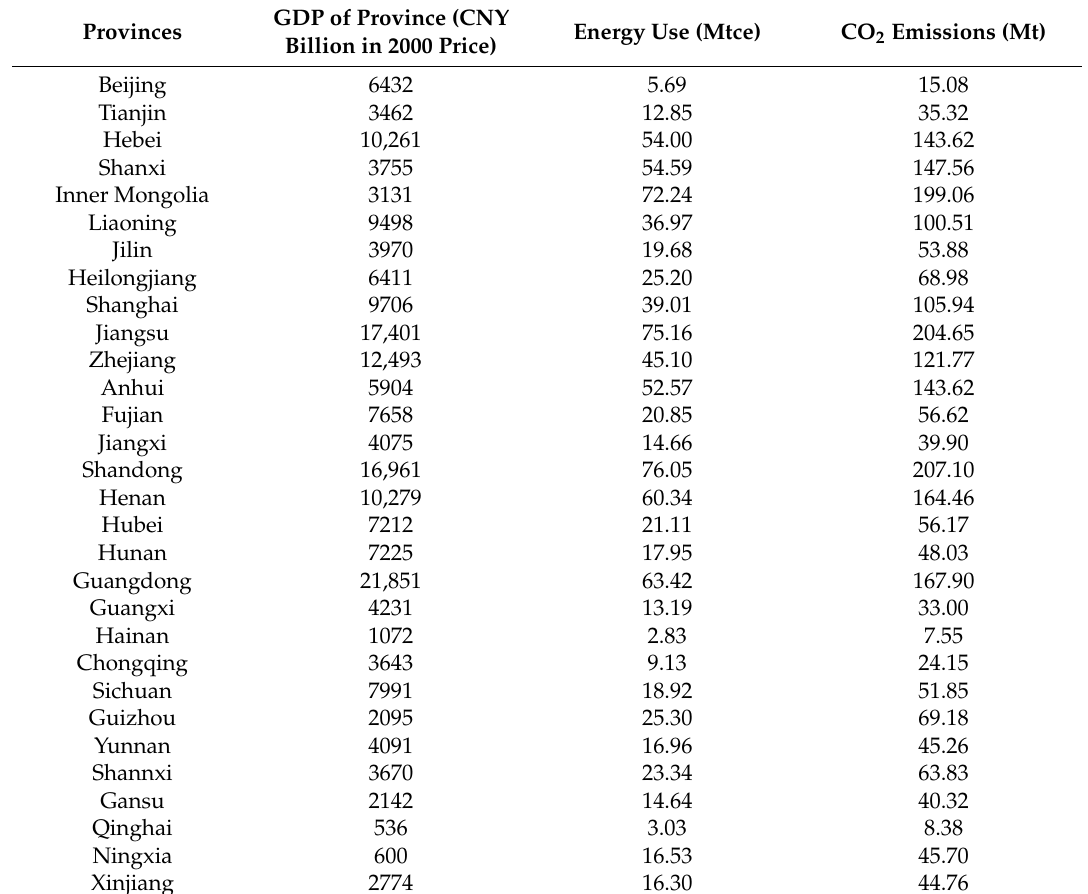
Table 3. Mean values of absolute variables for the 30 provinces in China,